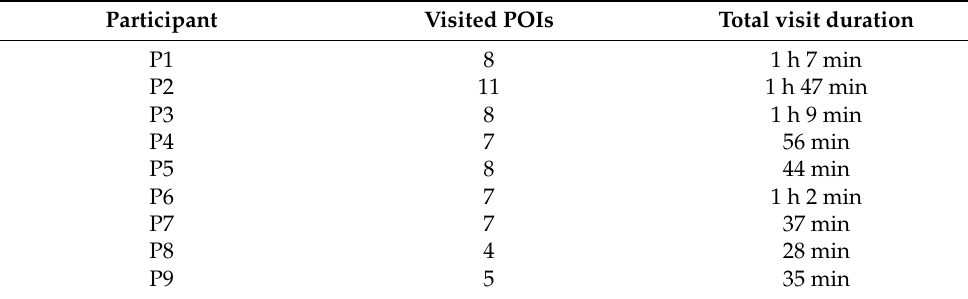
Table 4. Number of visited POIs and total visit duration per participant.